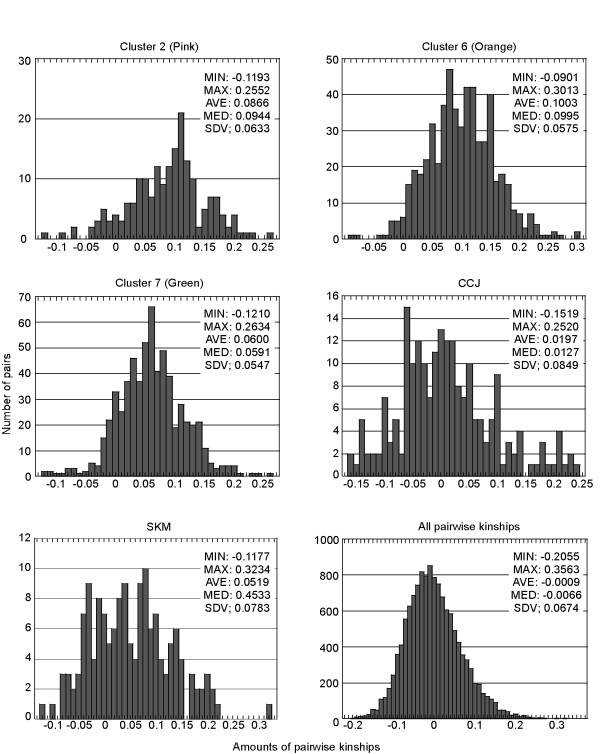
Distribution of the pairwise kinship coefficient between individuals supported by 90% probability intervals of Q within each cluster. Clusters 2, 6 and 7 correspond to the pink, orange and green clusters shown in Figure 4. MIN, MAX, AVE, MED and SDV represent minimum value, maximum value, mean, median and standard deviation, respectively, for each dataset.